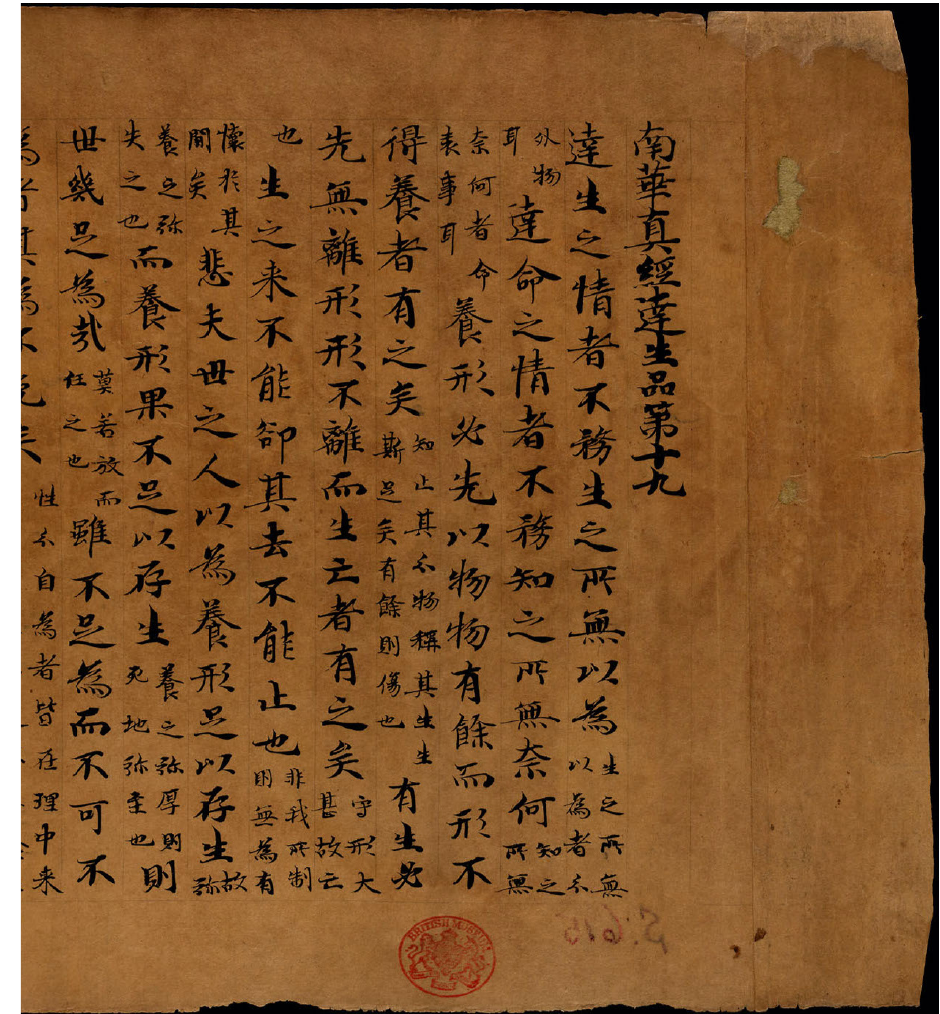
Figure 2. Beginning of the Zhuangzi ’s chapter 19, titled “Understanding Life” (“Dasheng” 達生 ). Found in the Dunhuang caves and purchased by Sir Marc Aurel Stein (1862–1943). Photo courtesy of the British Library, Or.8210/S.615R, © The British Library Board. The title and main text are printed using large characters. Guo Xiang’s 郭象 (c. 252–312 CE) commentary to the Zhuangzi , however, is printed in two columns using smaller